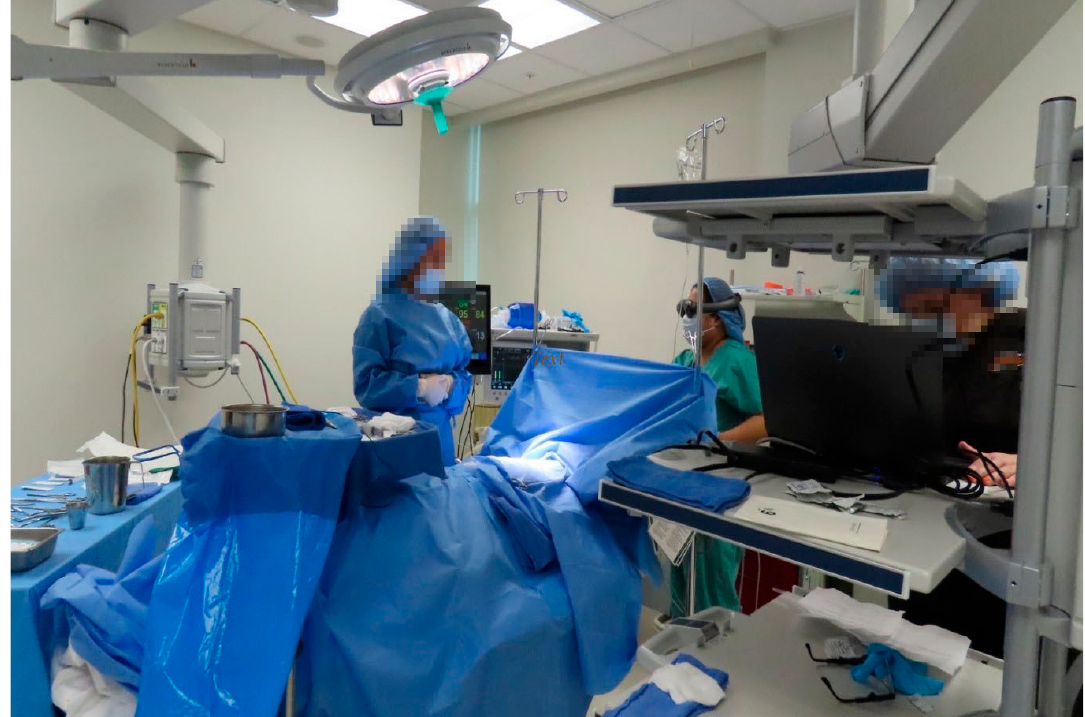
Figure 7. Student registered nurse anesthetist (SRNA) involved in simulated scenario with faculty members as confederates. Photo by Julian Narchet. Source: innovate.it.miami.edu.